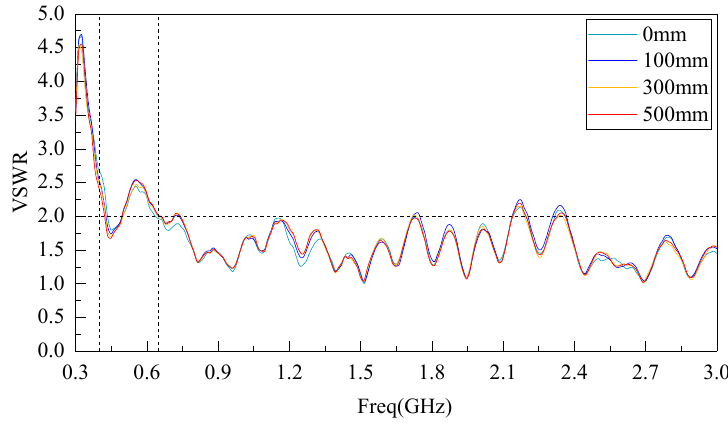
Figure 10. Measured VSWR curve.